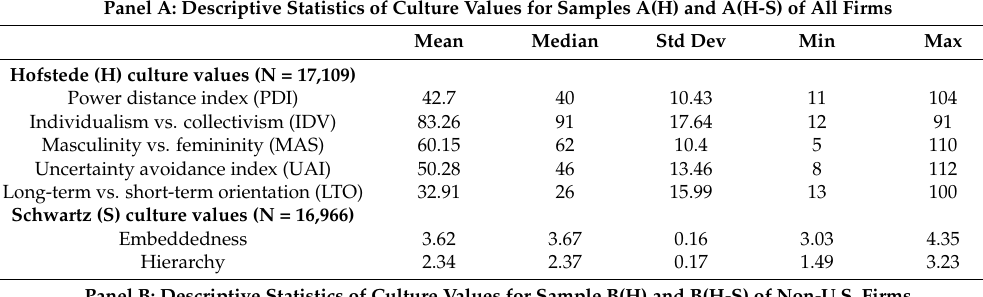
Table 3. Descriptive statistics of national culture